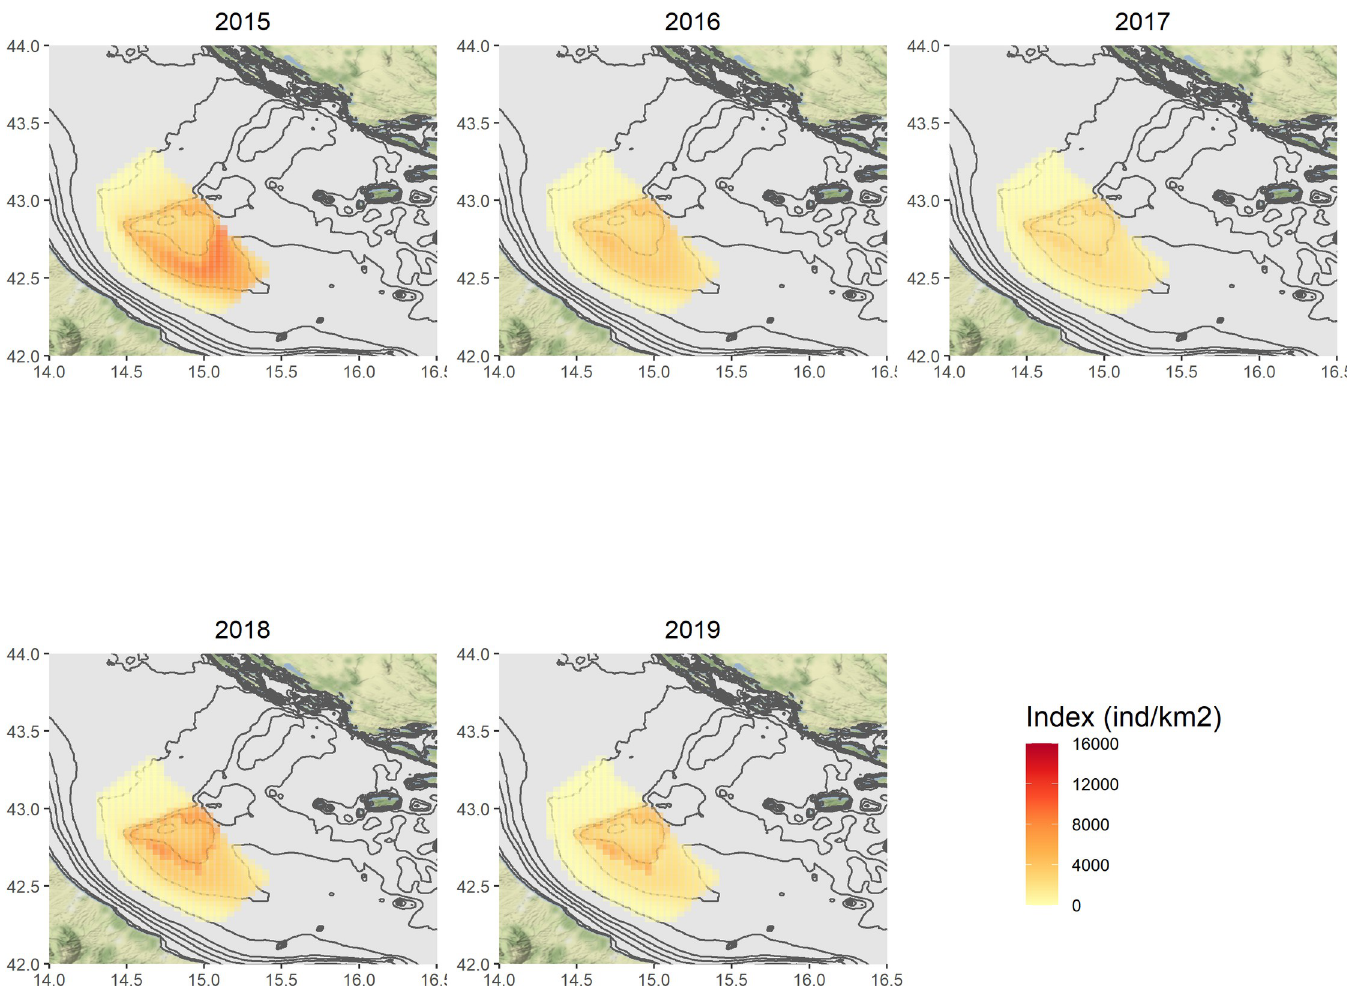
Fig 7. Predicted spatial distributions of Nephrops density index (N/km 2 ) for the autumn time series. Maps were made using the ggmap package [108] for R. Bathymetry layer source: [75]. Map tiles by Stamen Design, under CC BY Data by OpenStreetMap, under ODbL.